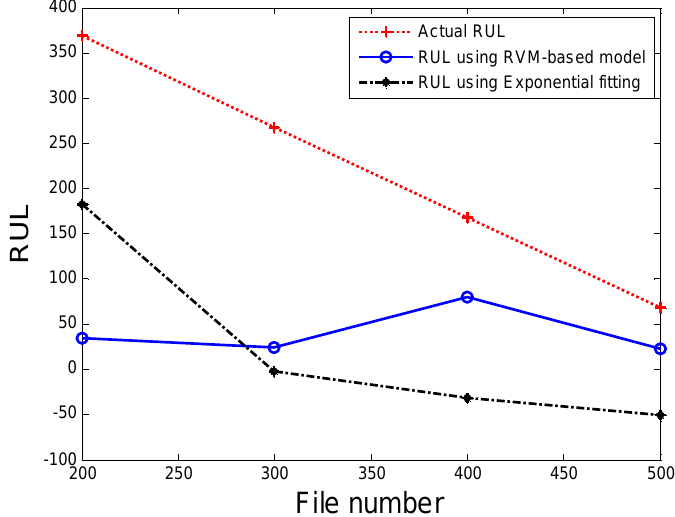
Figure 20. Comparison of prognosis performance using the RVM-based model and exponential fitting for dataset T2G1C4